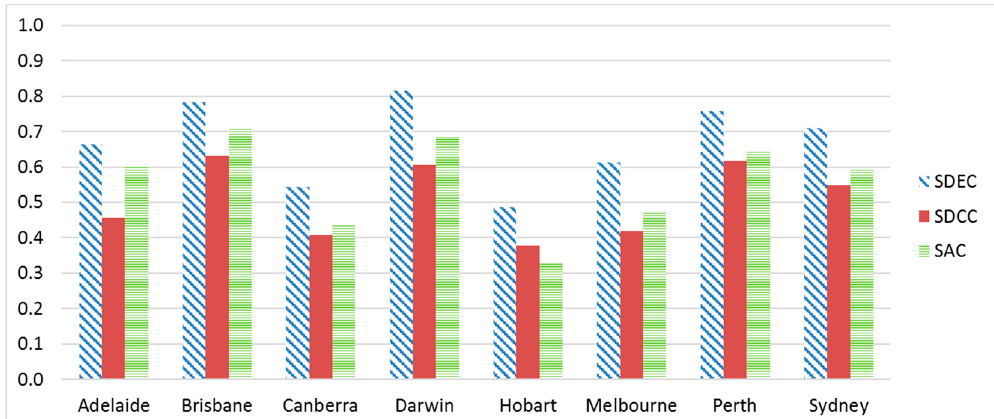
Figure 13. Annual solar fraction of different solar cooling systems.